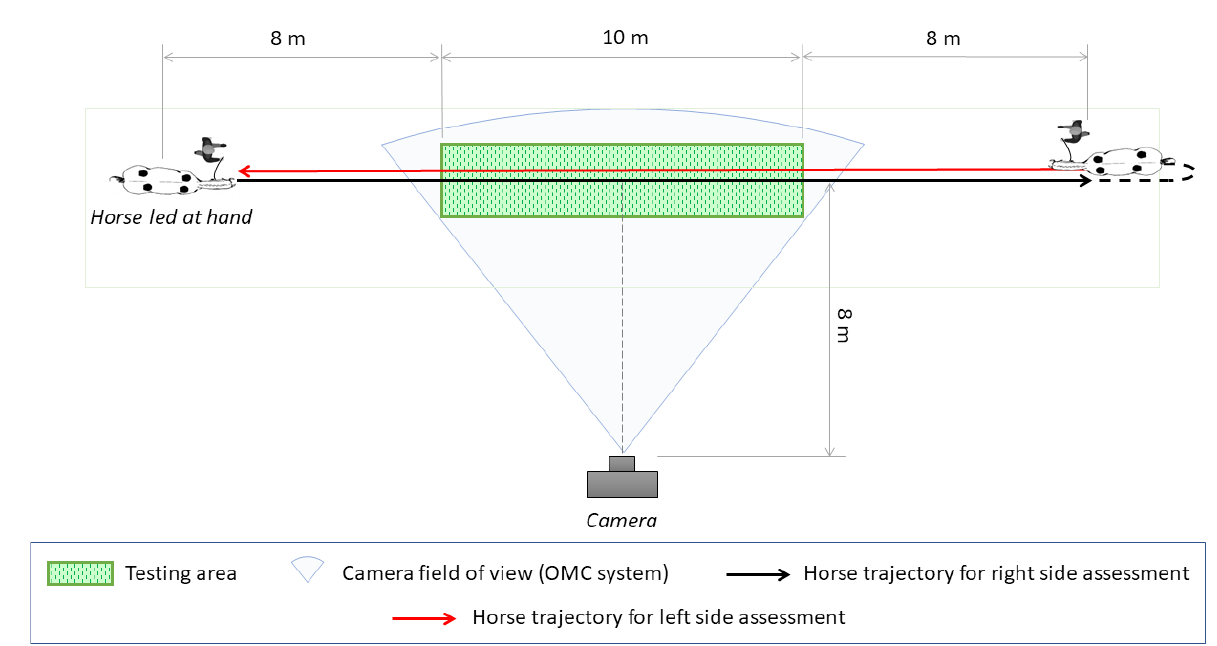
Figure 2. Schematic representation of the set up used for the standardized locomotion test per-